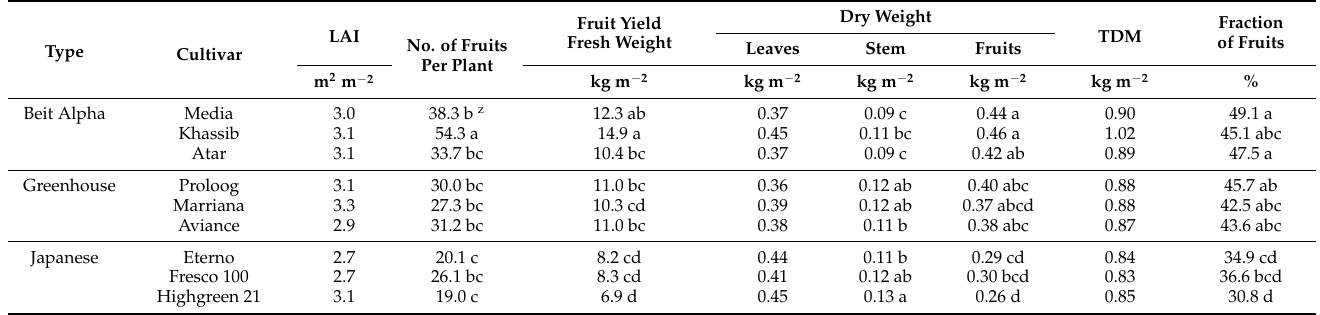
Table 1. LAI, number of fruits per plant, fruit yield fresh weight, leaf, stem and fruit dry weight, total dry matter (TDM), and fraction of fruits of nine cucumbers cultivars at 96 days after transplant- ing.